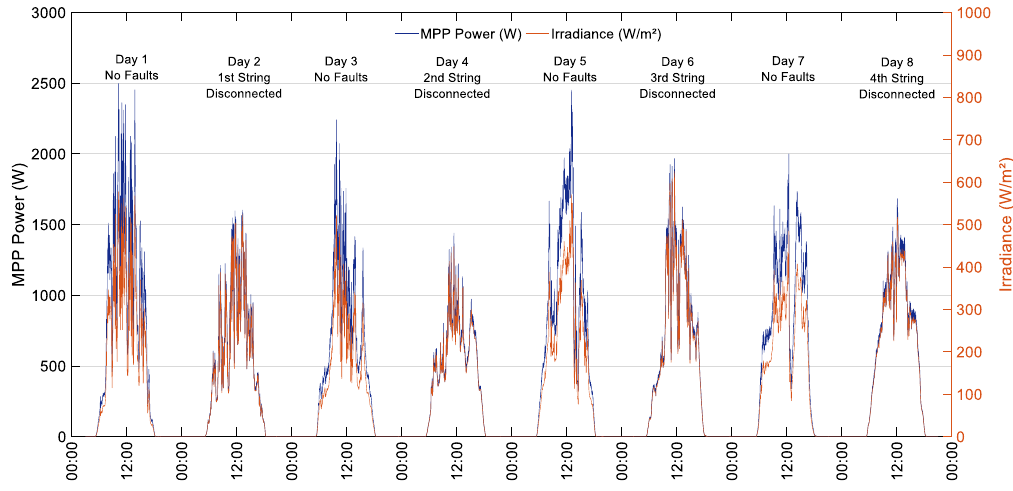
Figure 17. System 2 experimental results for irradiance G and P MPP.